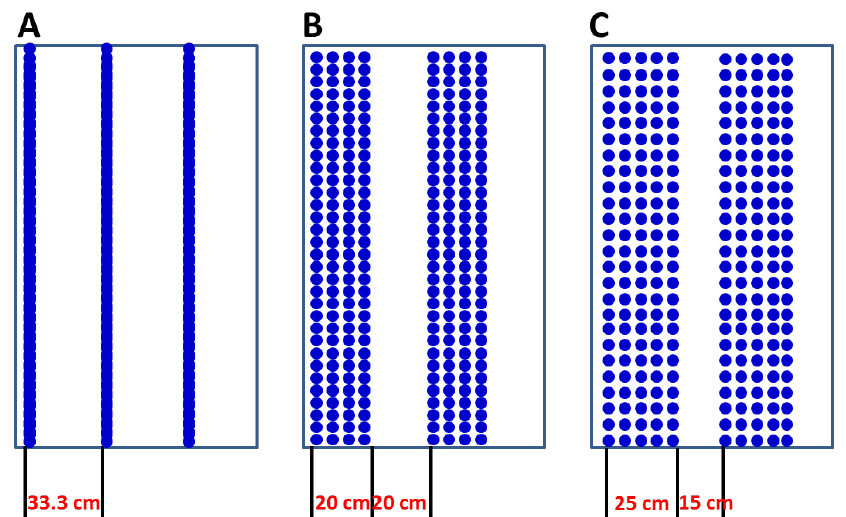
Figure 1. The three sowing patterns (( A ): line and dense sowing with 33.3 cm row space (LDS). ( B ): belt uniform sowing with 20 cm row space (BUN). ( C ): belt uniform sowing with narrow (15 cm) row space (BUW)) used in this study. All sowing patterns have the same seed rate.